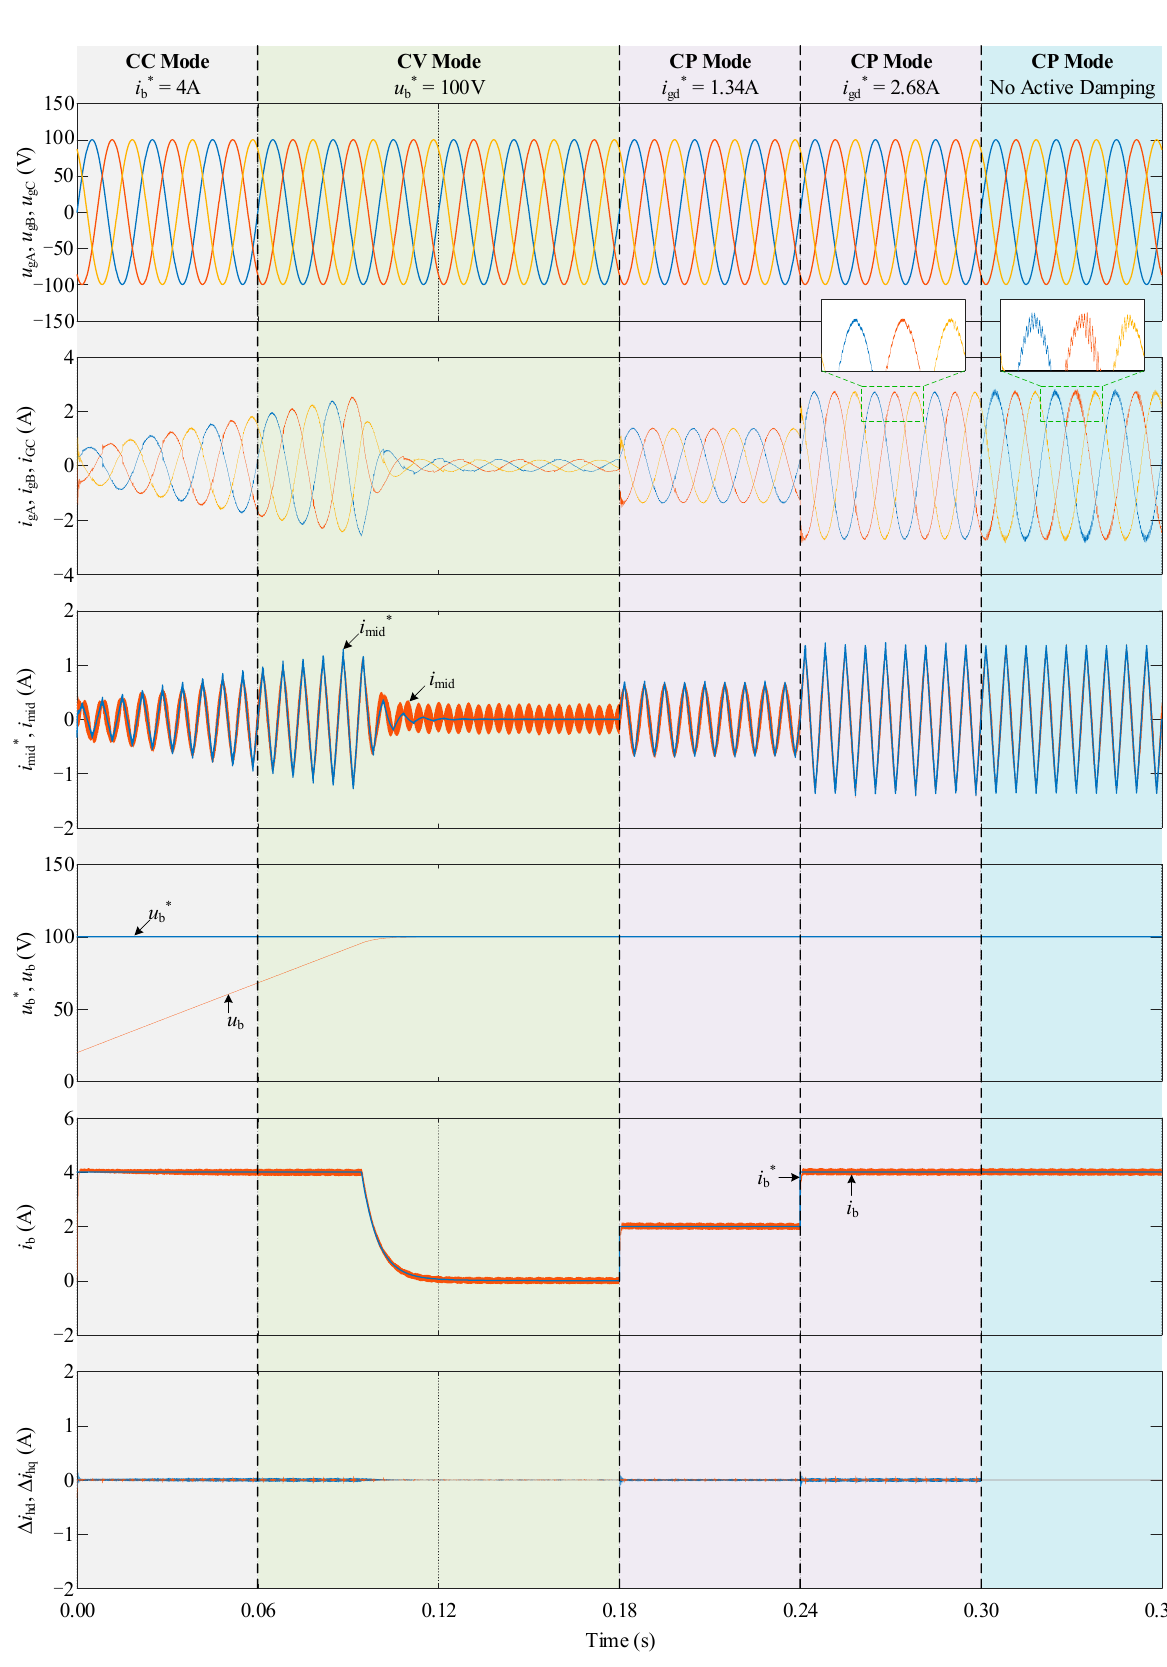
Figure 10. Simulation results of H3C-BESS under different working modes with and without active damping function